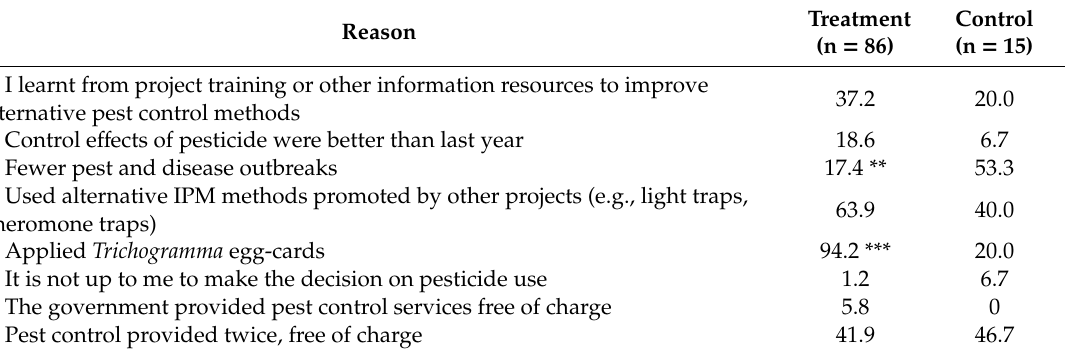
Figure 1. Trend in use of pesticides between 2015 and 2017 for rice farmers in the project implementation area in Southwestern China, based on farmers responses to the household questionnaire surveys (HHS) (Chi 2 = 14.9, p < 0.001). Table 6. Reasons for a decrease in pesticide use reported by rice and maize farmers during the HHS between 2015 and 2017, values given as a percentage.